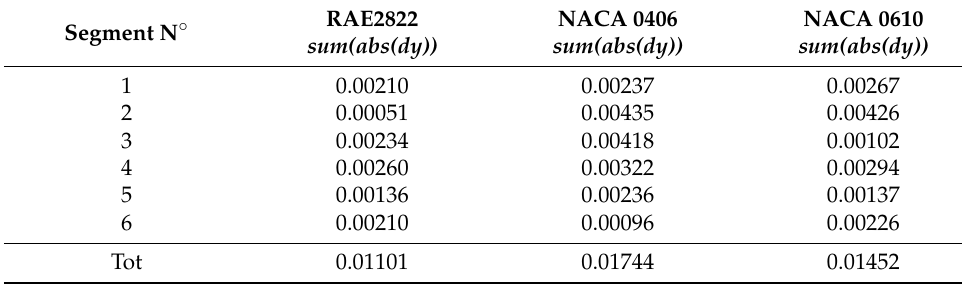
Table 11. New mathematical model fitting process geometrical approximation.